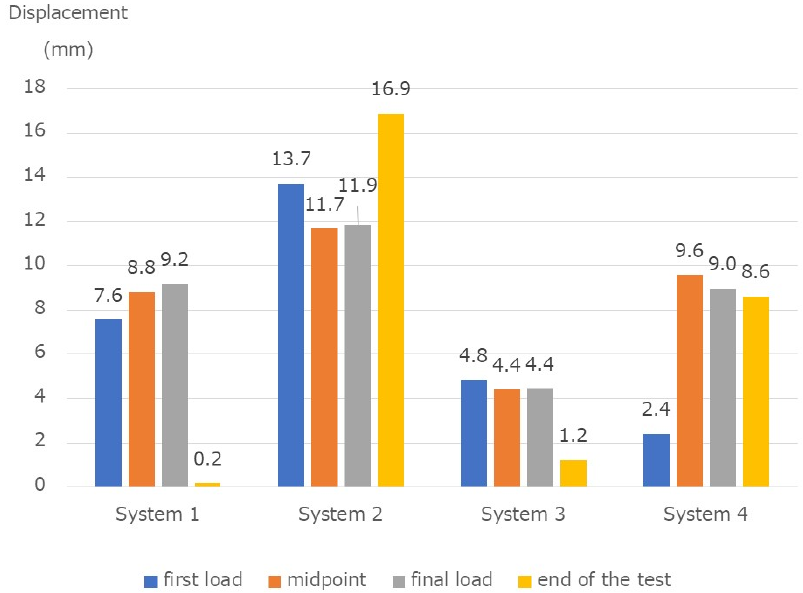
Figure 8. Fatigue test results. Displacement during one cycle at the first load, at the midpoint in the fatigue test, before the end of the test, and displacement after the end. The four systems showed statistically significant differences between them.